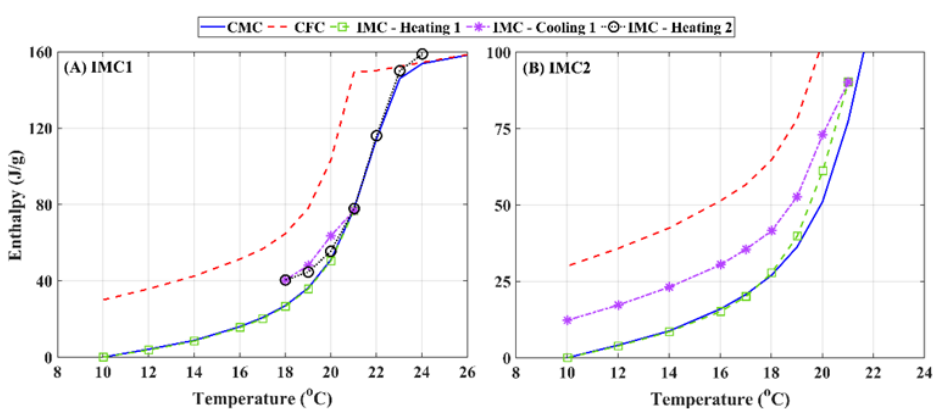
Figure 5. Temperature–enthalpy curves of ( A ) IC1 and ( B ) IC2 tests superimposed on CMC and CFC curves.